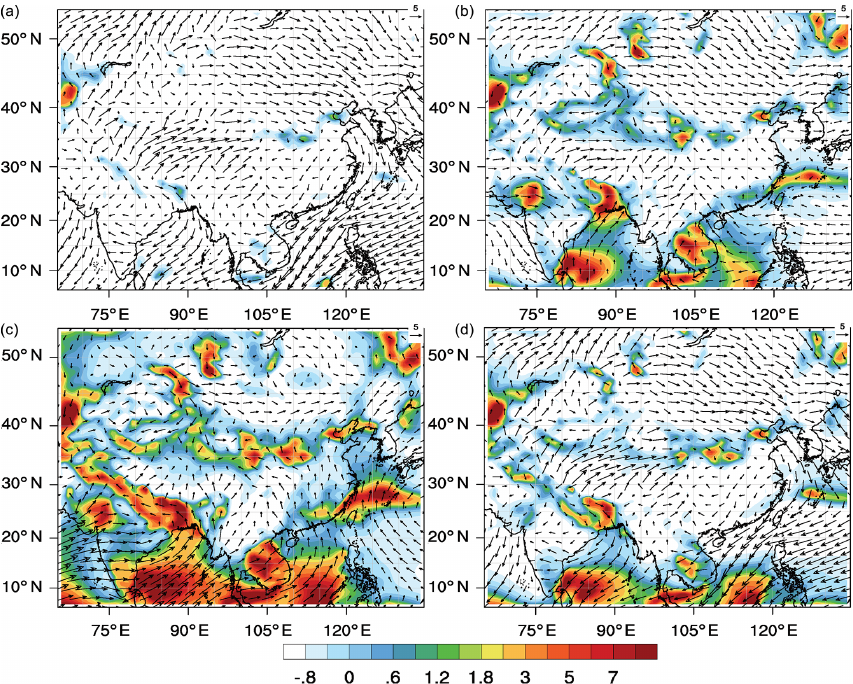
Figure 5. Modeled mean near-surface wind fields (winds at 10ma.g.l.) and the monsoon index in the boundary layer (0–1.5km) for winter (December, January, and February; a ), spring (March, April, and May; b ), summer (June, July, and August; c ), and autumn (September, October, and November; d